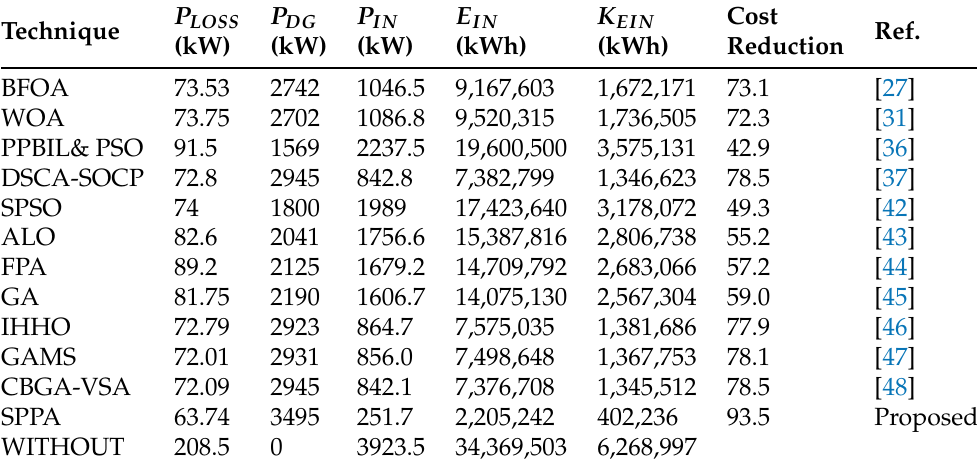
Table 3. Cost reduction comparison of NW-1.